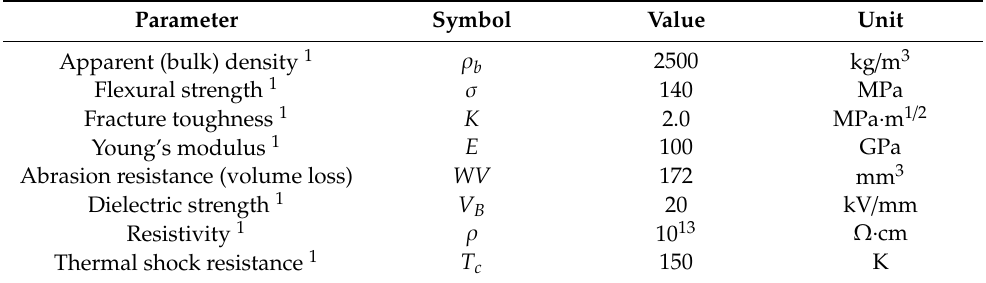
Table 1. Properties of the high-strength aluminous porcelain used to construct the dielectric window.